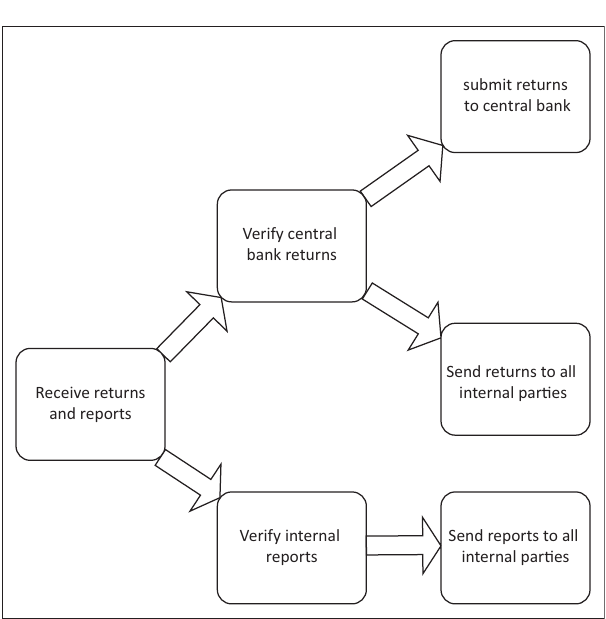
FIG URE 15: Workflow of capital